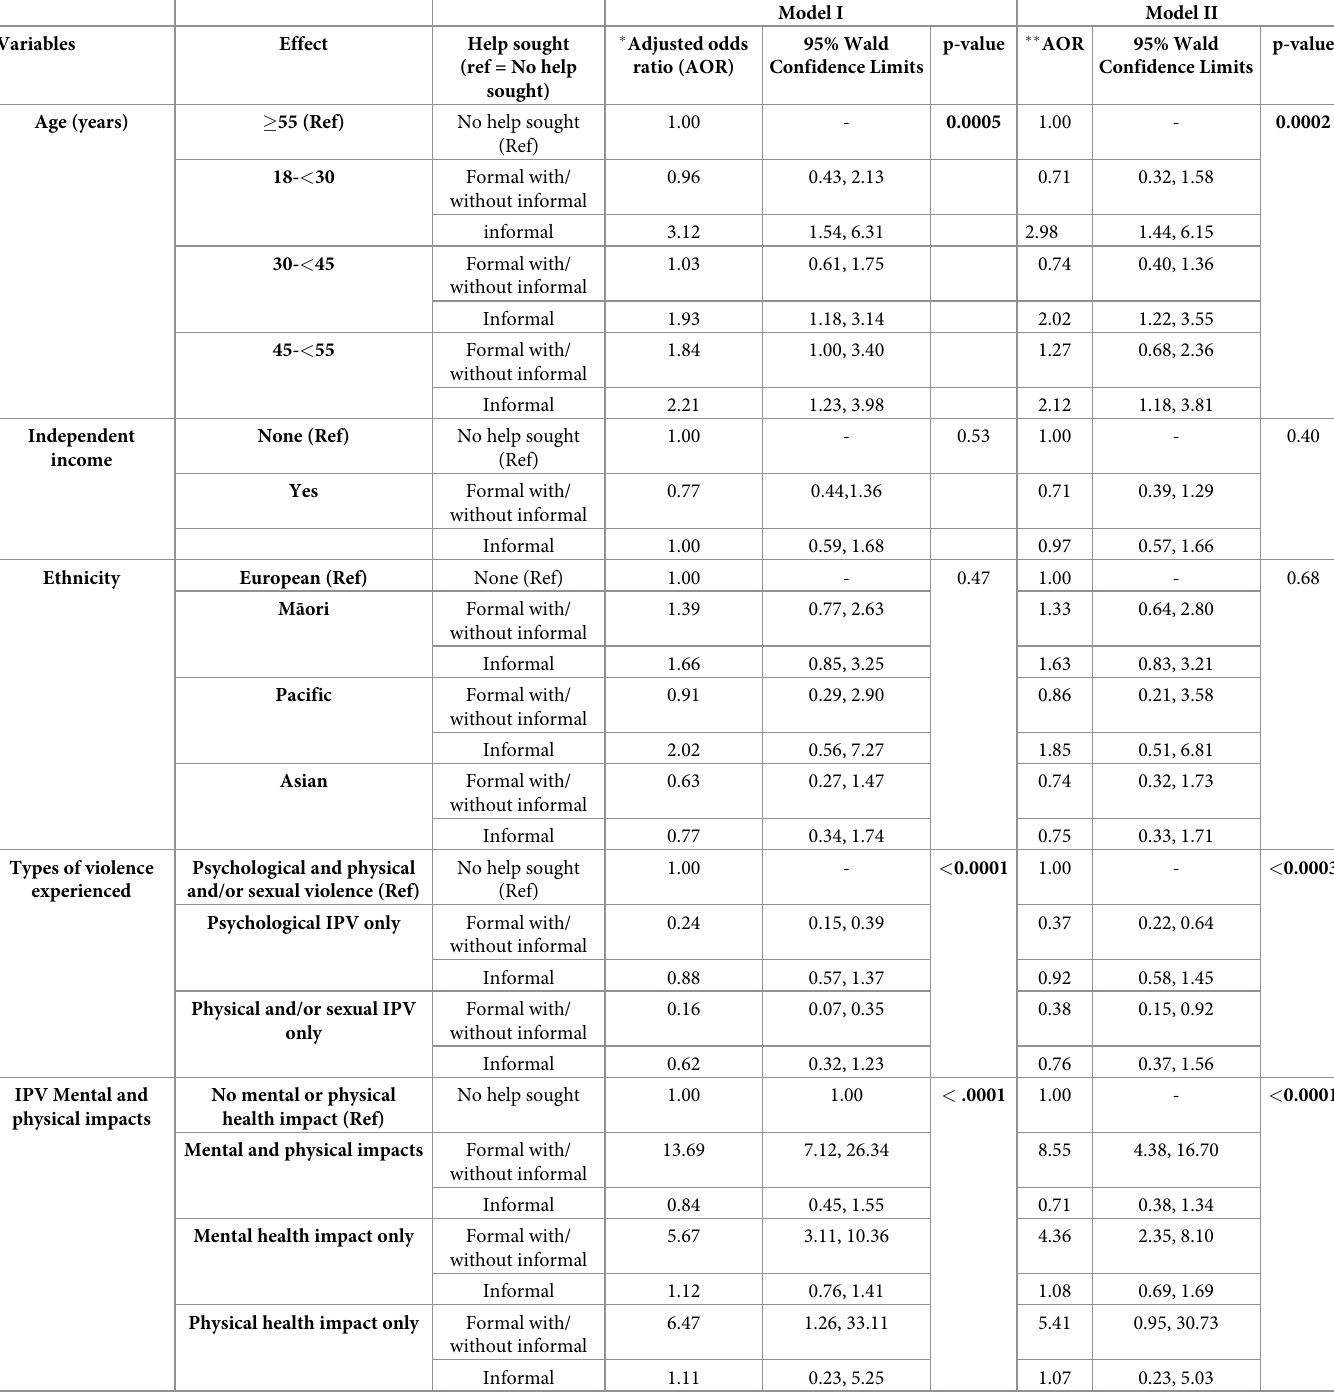
Table 3. Association between women’s formal/informal help-seeking and types of violence experienced, impacts of violence experienced, number of children and social belonging, controlling for demographic factors (n =